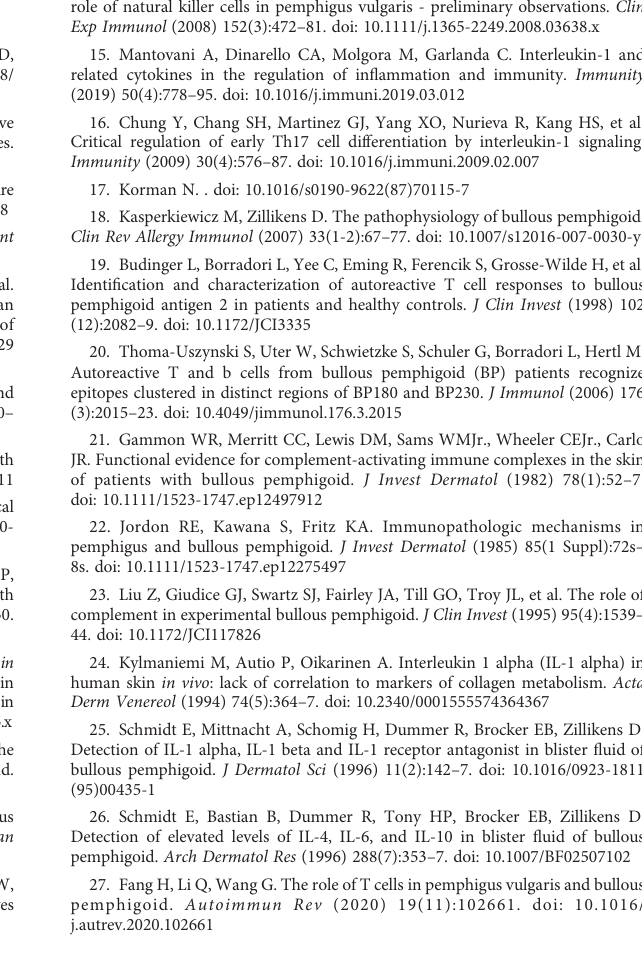
SUPPLEMENTARY FIGURE 1 HaCaT cells were irradiated with the indicated intensity of UVA. After an incubation period of four hours, the expression of IL1A and IL1B was measured by